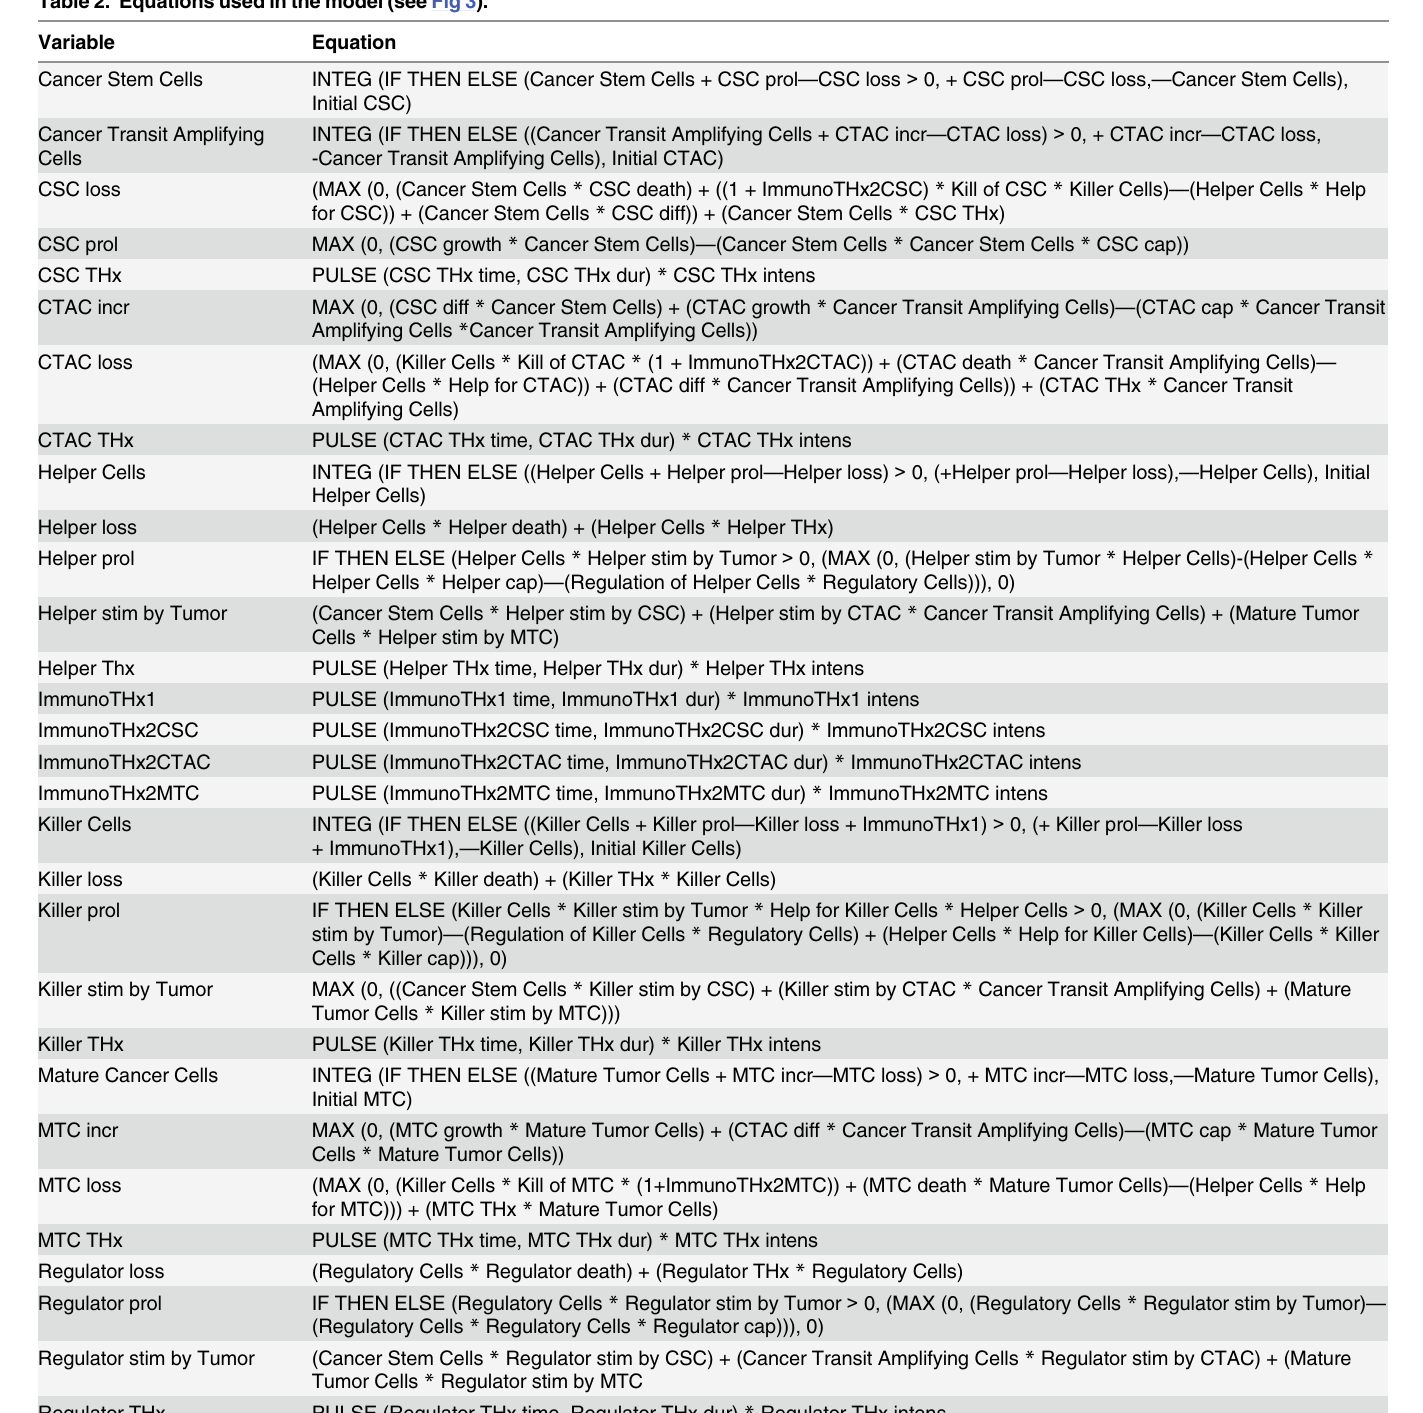
Table 2. Equations used in the model (see Fig